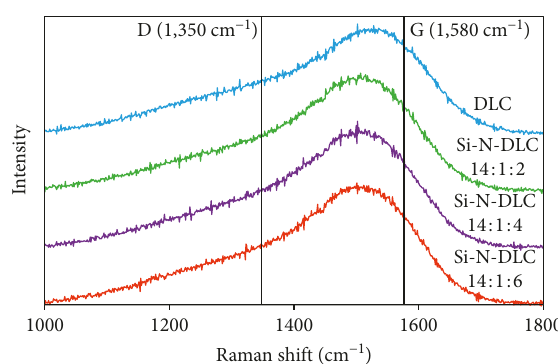
Figure 4: Raman spectra of pure DLC and Si-N-DLC films at different flow rate